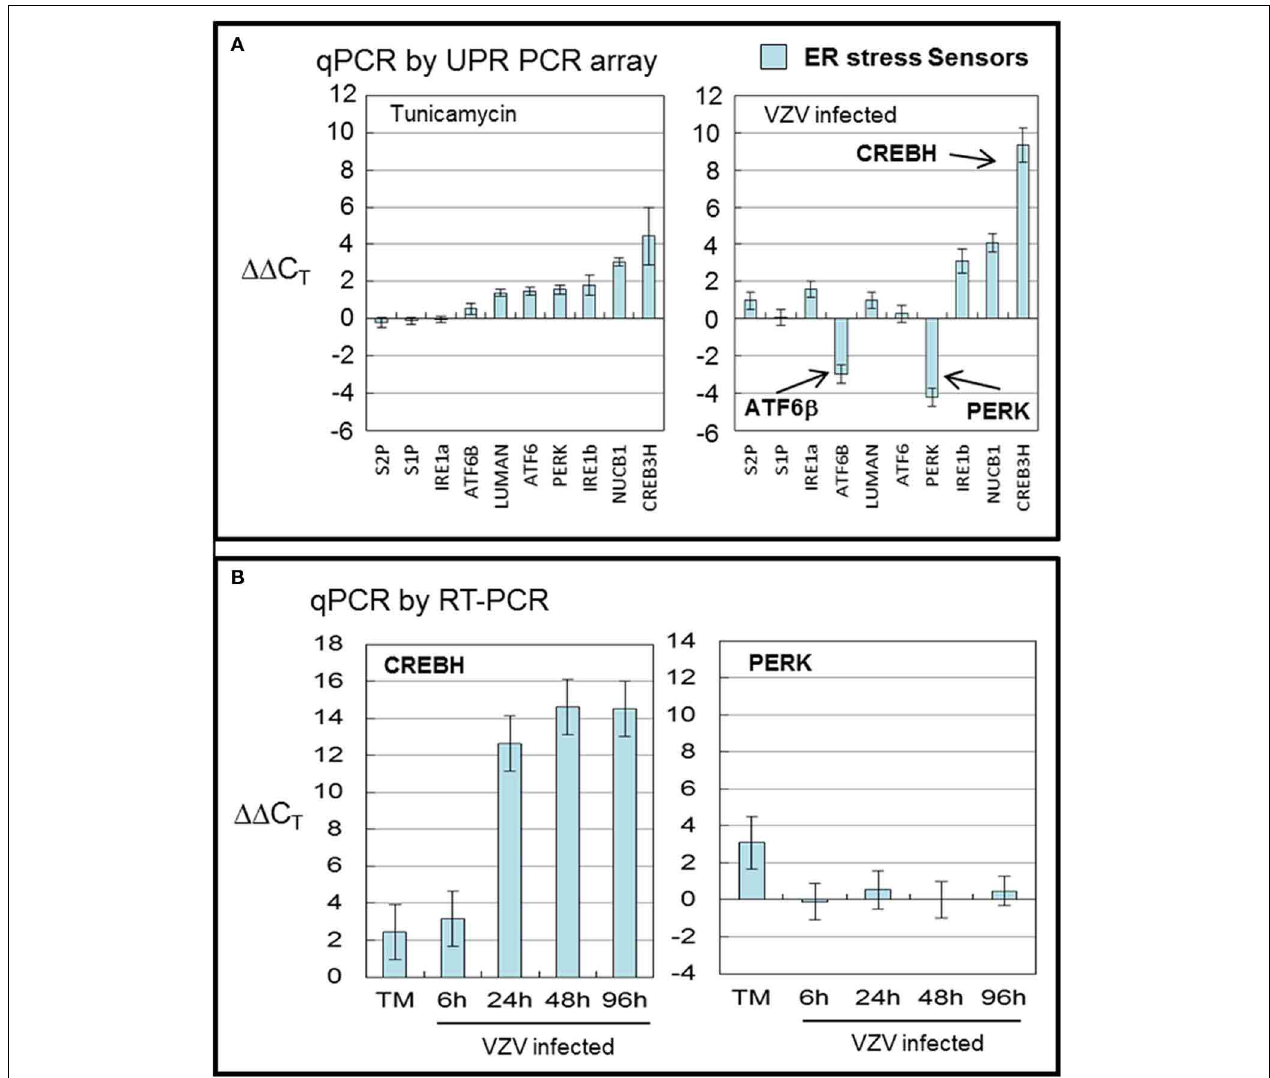
FIGURE 3 | VZV infection significantly upregulated the transcription factor CREBH . Human fibroblast cells (MRC-5) were grown in tissue culture plates then infected with VZV-32 infected MRC-5 cells or treated with tunicamycin (TM), a N-glycosylation inhibitor. At 72 hpi, RNA was processed as described in legend to Figure 2 . All gene transcription measurements were graphed for tunicamycin treated and VZV infected cell samples. (A) By measurements using the UPR specific PCR array, VZV